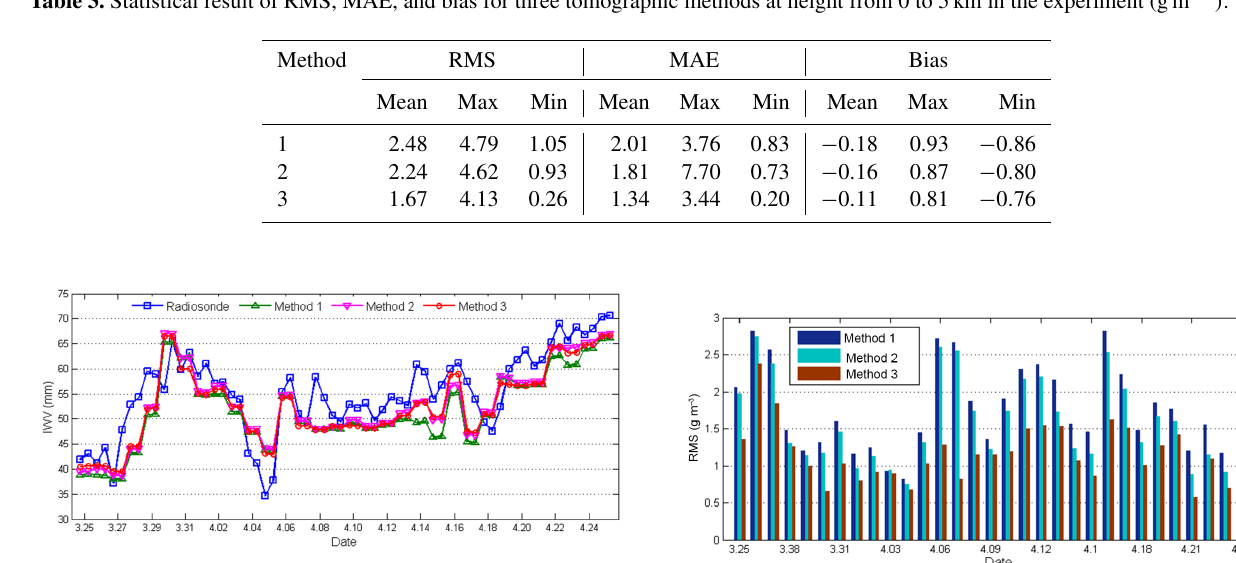
Table 3. Statistical result of RMS, MAE, and bias for three tomographic methods at height from 0 to 5km in the experiment (gm − 3 ) .